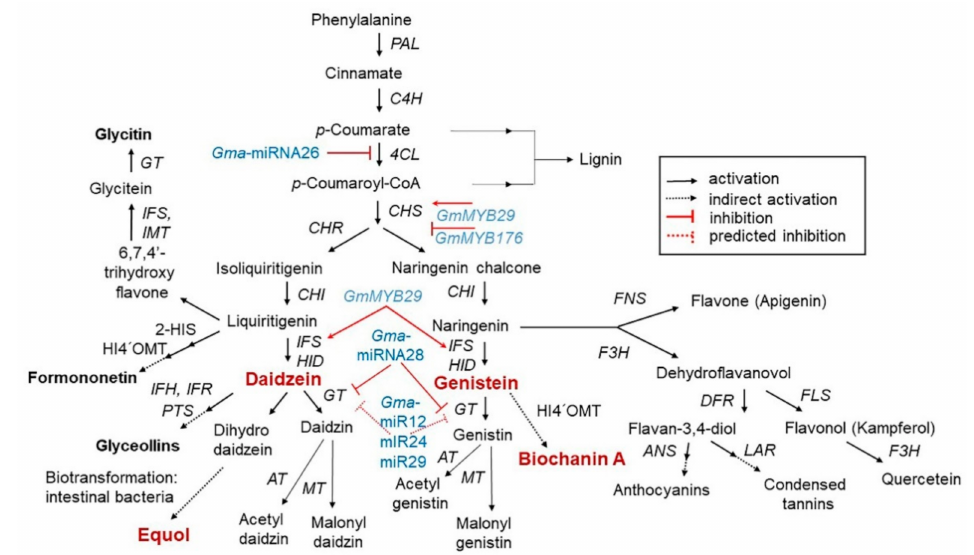
Figure 1. Schematic representation of the phenylpropanoid pathway, showing the key intermediates and enzymes associated with isoflavone biosynthesis, and partial regulation pathway. Isoflavones are biosynthesized via a phenylalanine-dependent pathway in the presence of a wide range of enzymes. Regarding regulation, GmMYB29 activates chalcone synthase (CHS) expression, whereas GmMYB176 inhibits CHS expression. Furthermore, Gma-miRNA26, Gma-miRNA269, and Gma- miRNA28 suppress the gene expression or enzymatic activity of 4-coumarate-CoA ligase (4CL), isoflavone synthase (IFS), and glucosyltransferase (GT), respectively. Dotted lines represent the unclear role of miRNA in the pathway [18,19]. This isoflavone biosynthetic pathway is adapted from “USDA Database for the Isoflavone Content of Selected Foods Release 2.0 (http://www.ars.usda. gov/nutrientdata; accessed on 1 March